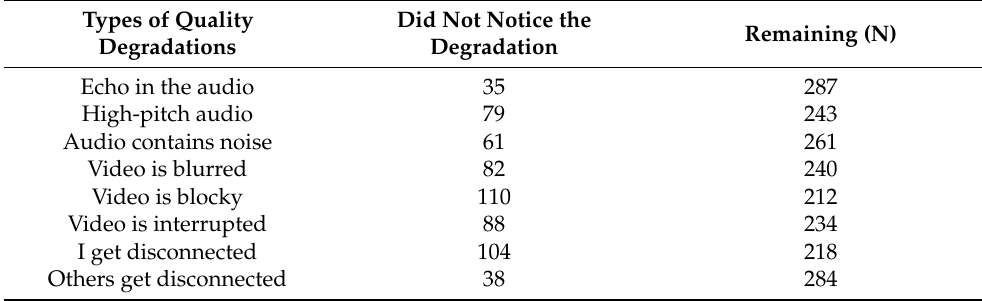
Table 2. The number of survey participants that did not notice the specific quality